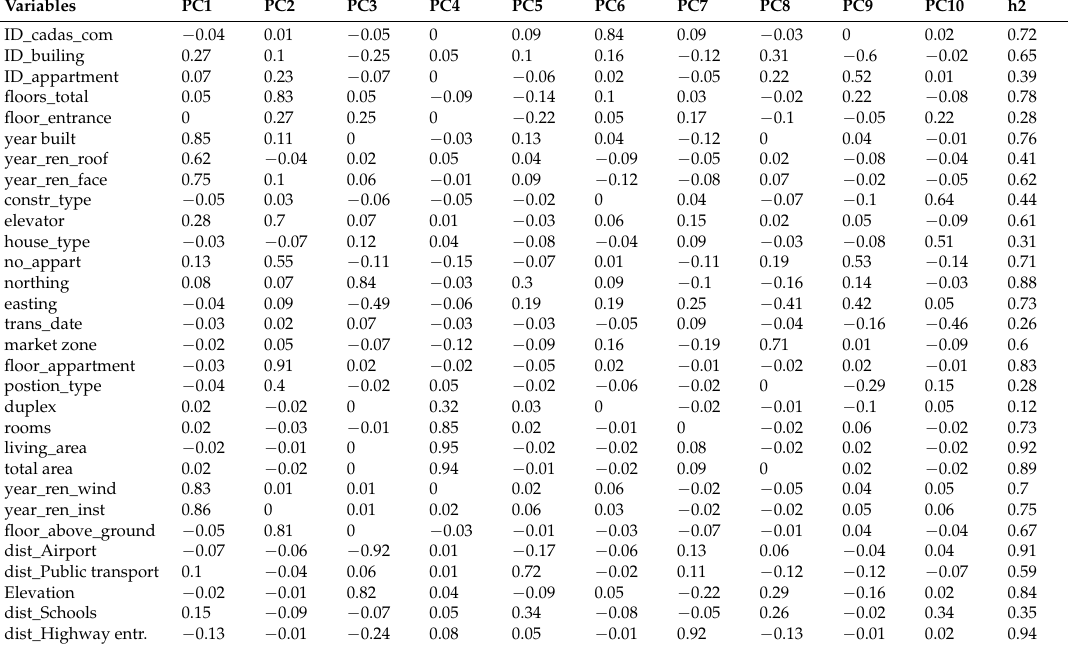
Table 2. The list of component loadings (PCis) and correlations to observed explanatory variables. Variables PC1